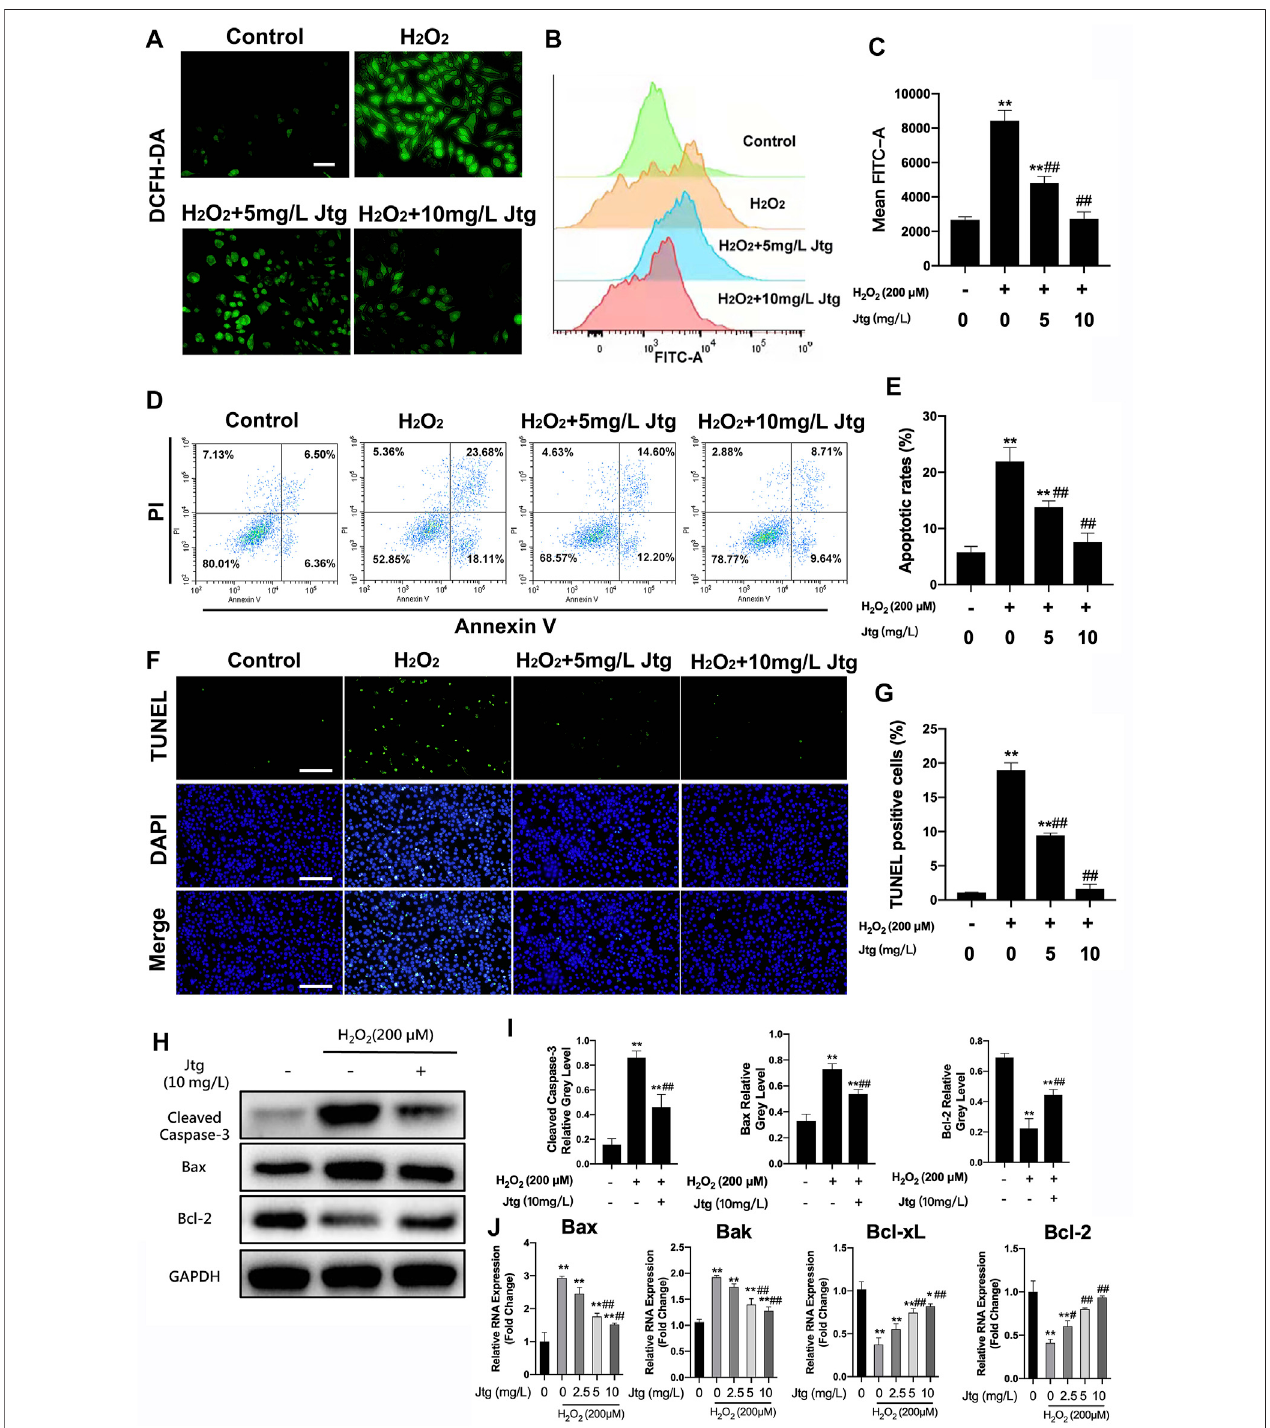
FIGURE 3 | Jtg ameliorates reactive oxygen species (ROS)-induced ATDC5 cell apoptosis. (A) The production of intracellular ROS detected by DCFH-DA probe, scalebar,50 μ m. (B) ROSpositivecellsweredetectedby fl owcytometryand (C) demonstratedasmeanFITC-Alevel. (D) Cellapoptosisassessedusing fl owcytometry and (E) statistical analysis. (F) Detection of apoptotic cells by TUNEL and DAPI staining assay, scale bar, 200 μ m and (G) statistical analysis. (H, I) Western blot assay was performed to analyze the expression of apoptosis-related proteins, including Cleaved Caspase-3, Bax and Bcl-2. (J) The expression of apoptosis-related mRNA, including Bcl-2 and Bcl-xL (anti-apoptotic) and Bax and Bak (pro-apoptotic), was analyzed using RT-PCR. *Compared with the control group and #compared with the H 2 O 2 without Jtg group (* p < 0.05, # p < 0.05; ** p < 0.01, ## p < 0.01).